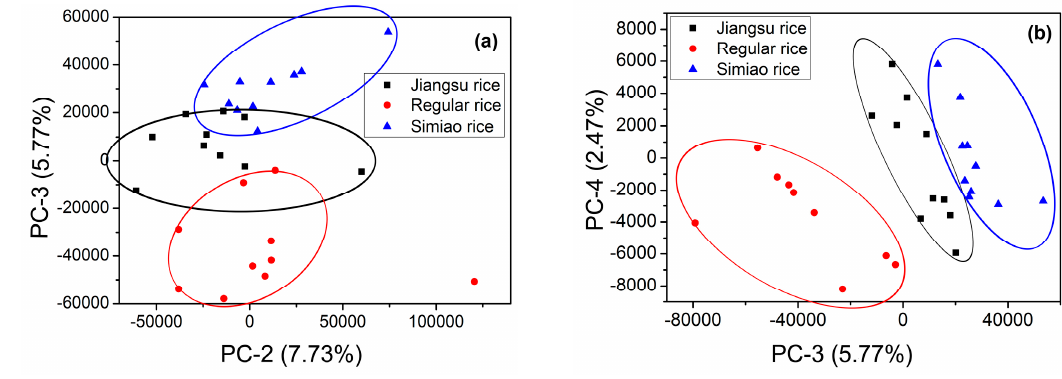
Figure 4. Scatter plots of PCA scores. ( a ) Scores plot of PC2 vs. PC3; and ( b ) scores plot of PC3 vs. PC4.